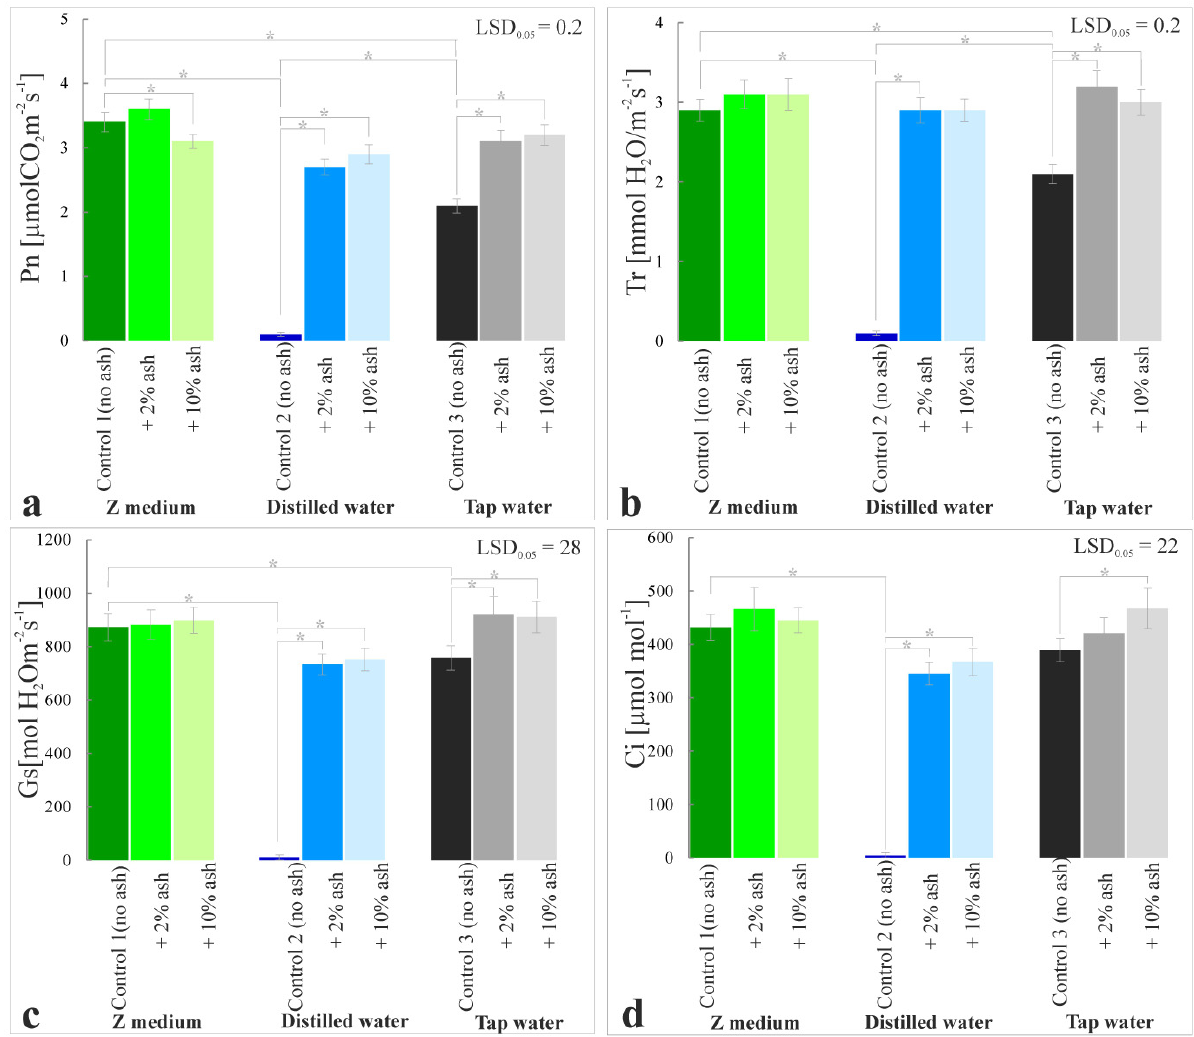
Figure 9 . Net photosynthesis, Pn ( a ), transpiration, Tr ( b ), stomatal conductance, Gs ( c ) and intercellular concentration of CO2, Ci ( d ) in the leaves of S. polyrrhiza plants grown on different variants of ash-supplemented media. Bars denote means ± SE; asterisks show statistically significant differences between particular series; LSD at alpha level of 0.05.